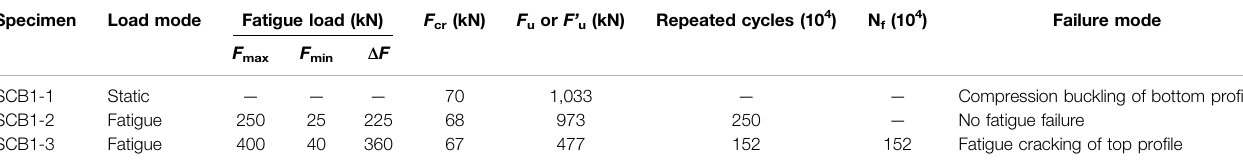
TABLE 3 | Typical experimental results.